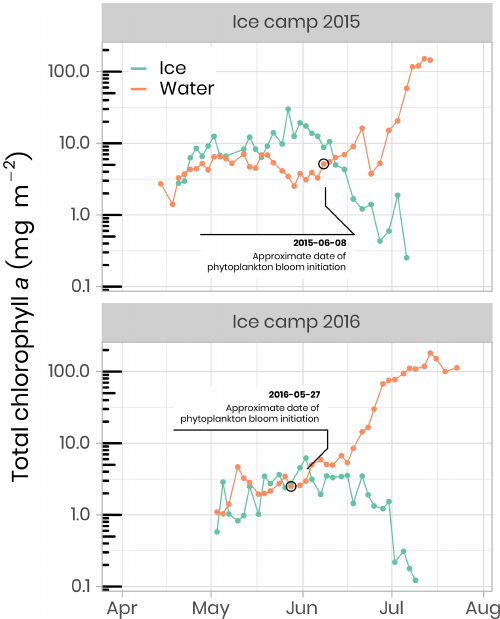
Figure 10. Temporal evolution of chlorophyll a in ice and water (depth-integrated) for both ice camp missions. Note that the water chlorophyll a have been integrated over the first 100m of the water column, whereas the ice chlorophyll a was measured on the bottom 0–10cm of the ice cores. The details of the calculations to deter- mine the approximate dates of phytoplankton bloom initiation can be found in Oziel et al.